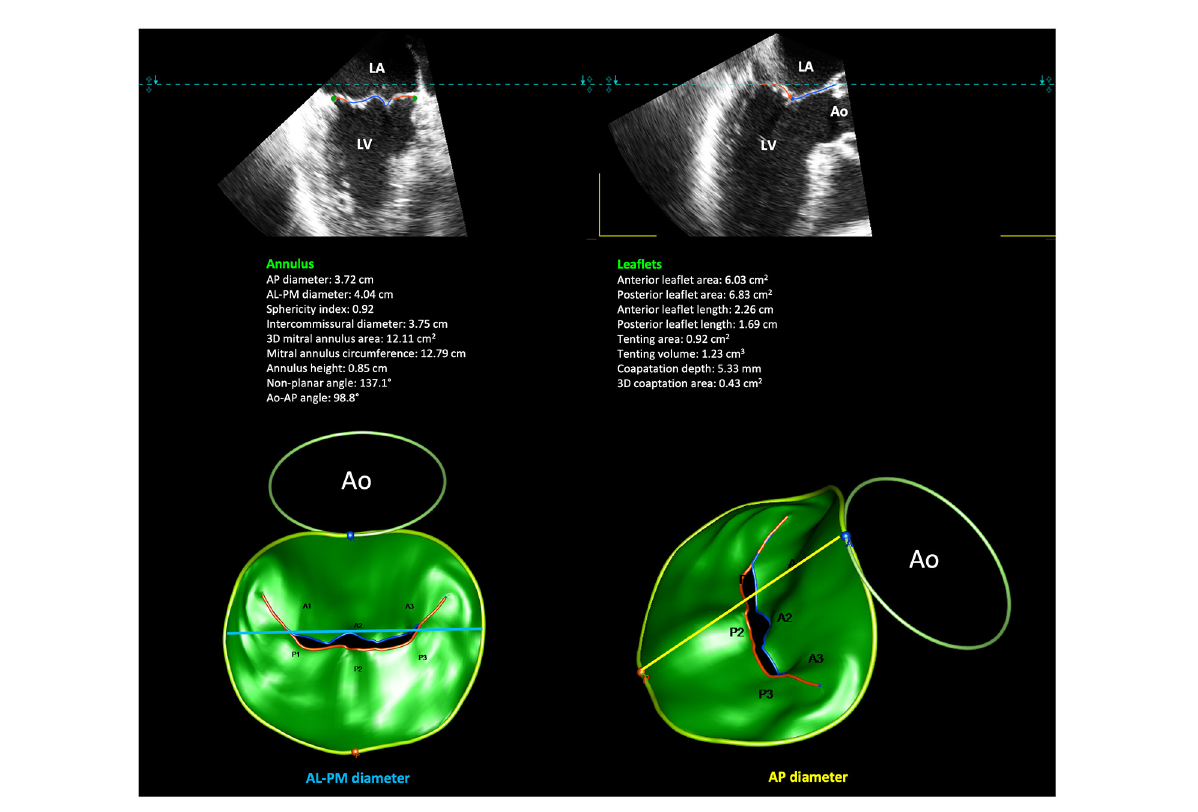
FIGURE5 Quantitative modeling of the MV leaflets and annulus by 3DE. Shown is an example of 3D MA reconstruction and semi-automatic computation of 3D MA and leaflets measurements in a case of P2 prolapse. 3DE, three-dimensional echocardiography. MA, mitral annulus.